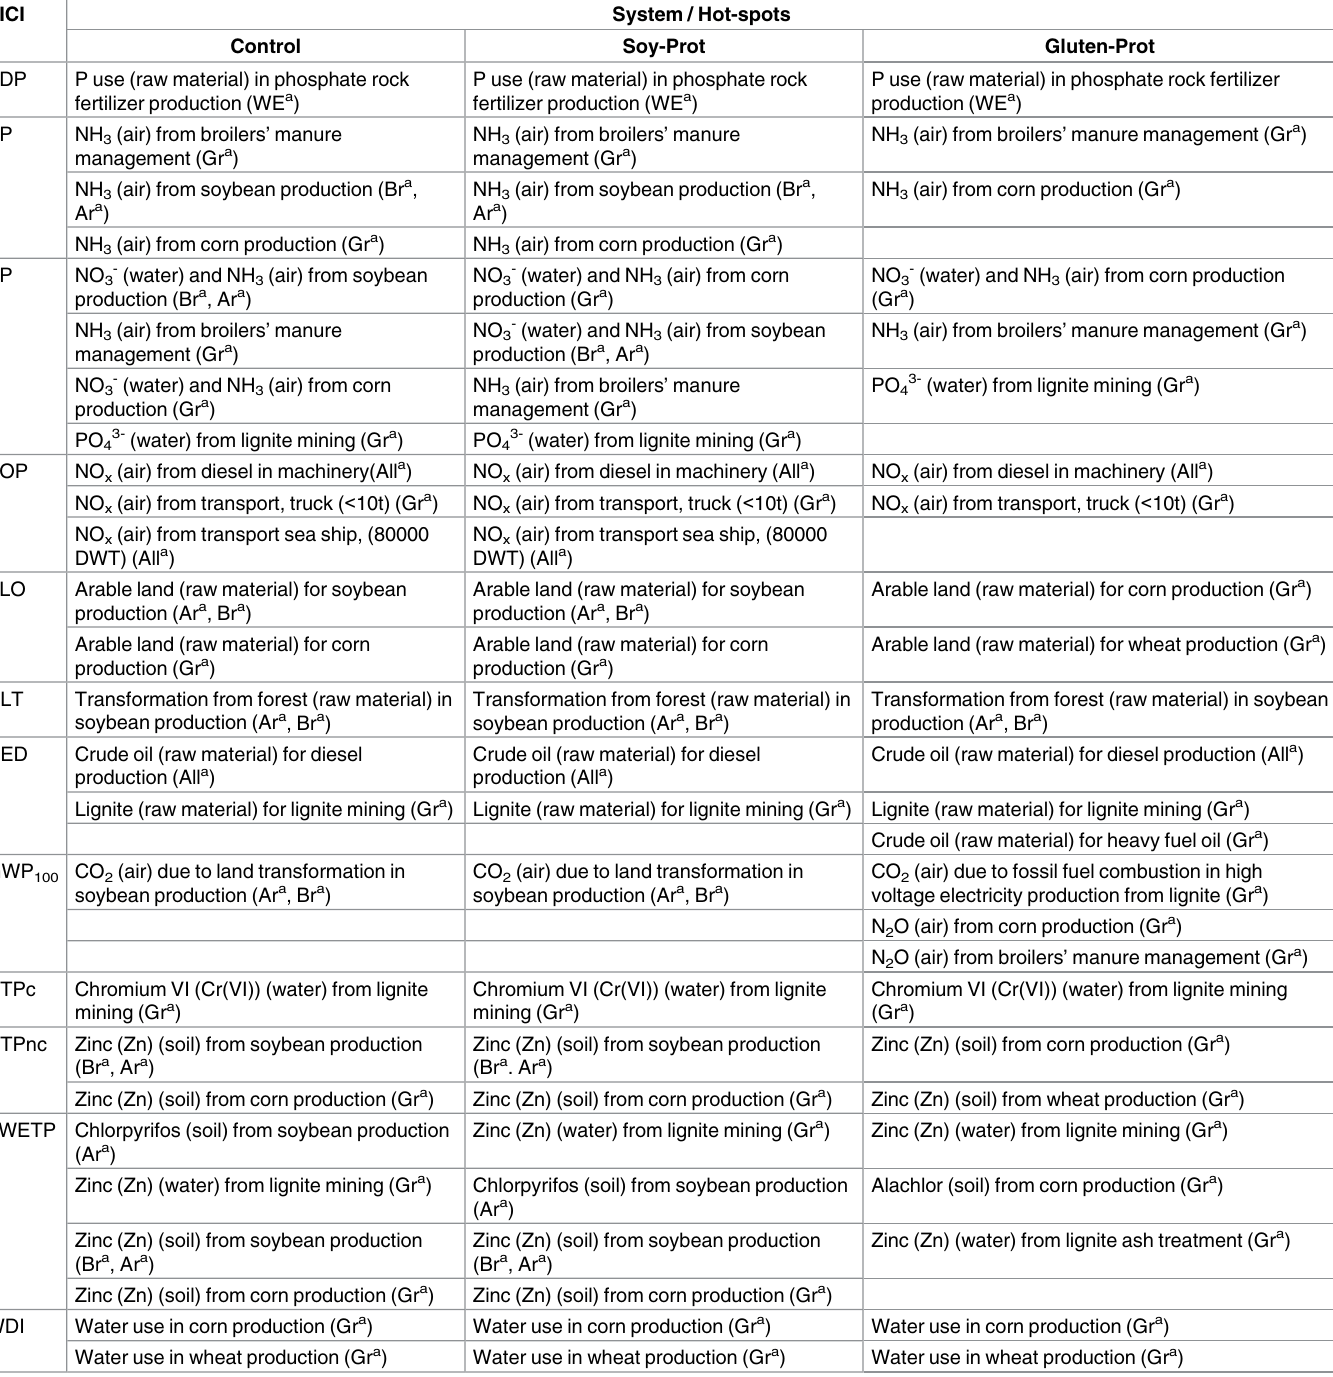
Table 13. Hot-spots for the EICIs and each